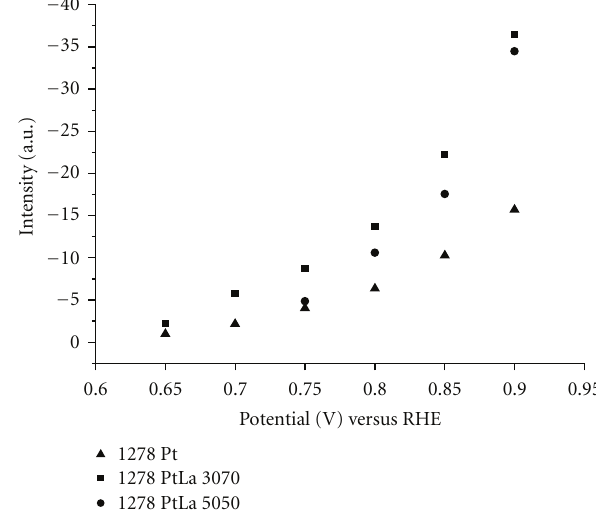
Figure 3: In situ FTIR spectra obtained in 1.0mol L − 1 CH 3 CH 2 OH + 0.1molL − 1 HClO 4 solution for PtLa/C (50: 50) electrocatalysts. P-polarized light; resolution: 8cm − 1 ; E ref = 0.05 V.